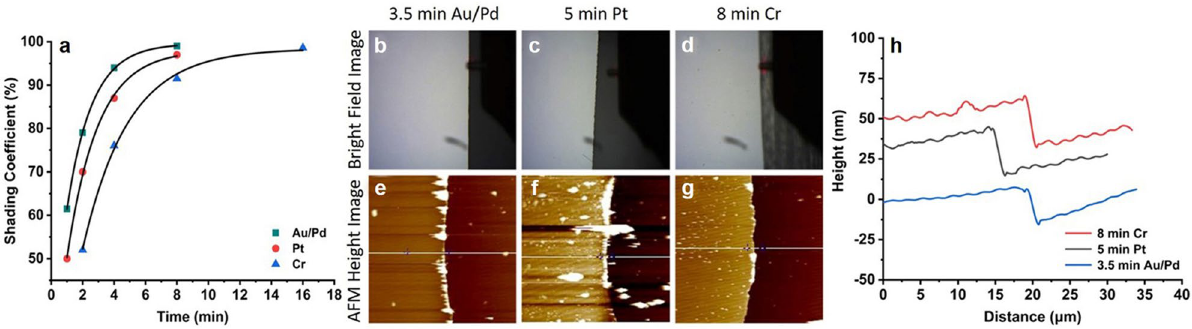
Figure 3. ( a ) Shading coefficient of three kinds of metals (Au/Pd, Pt, Cr) under different coating times (1, 2, 4, 8, 16 min); The bright field images ( b – d ), AFM height images ( e – g ) and thickness curves ( h ) of metal films under the optimized coating times.